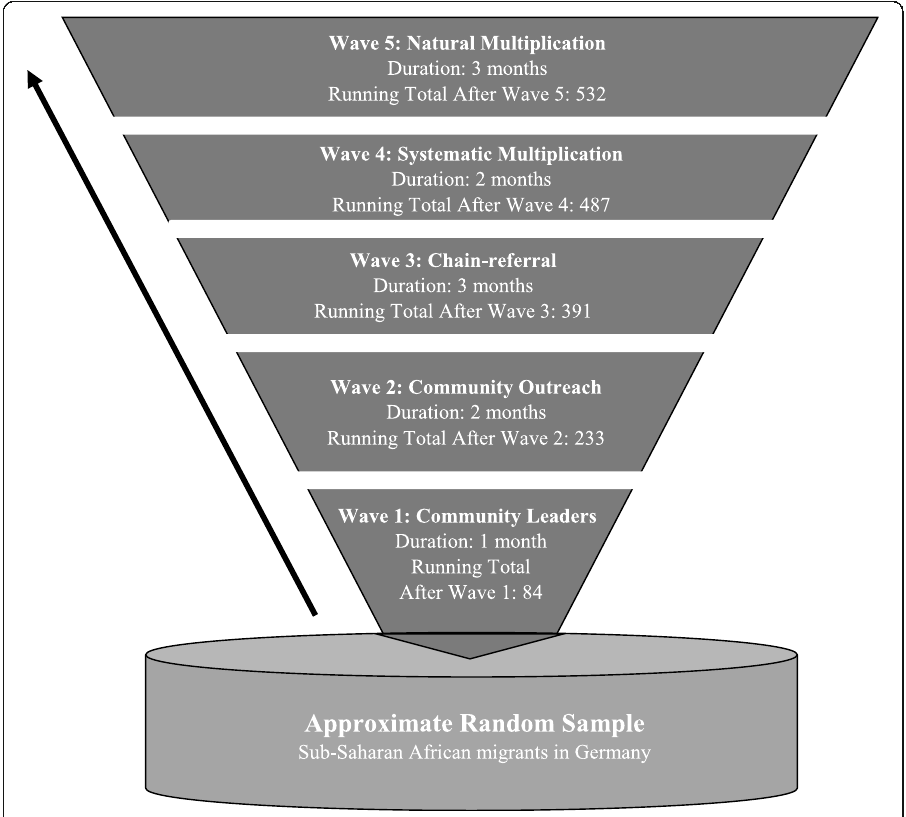
Fig. 1 The 5-Wave-Approach with results and